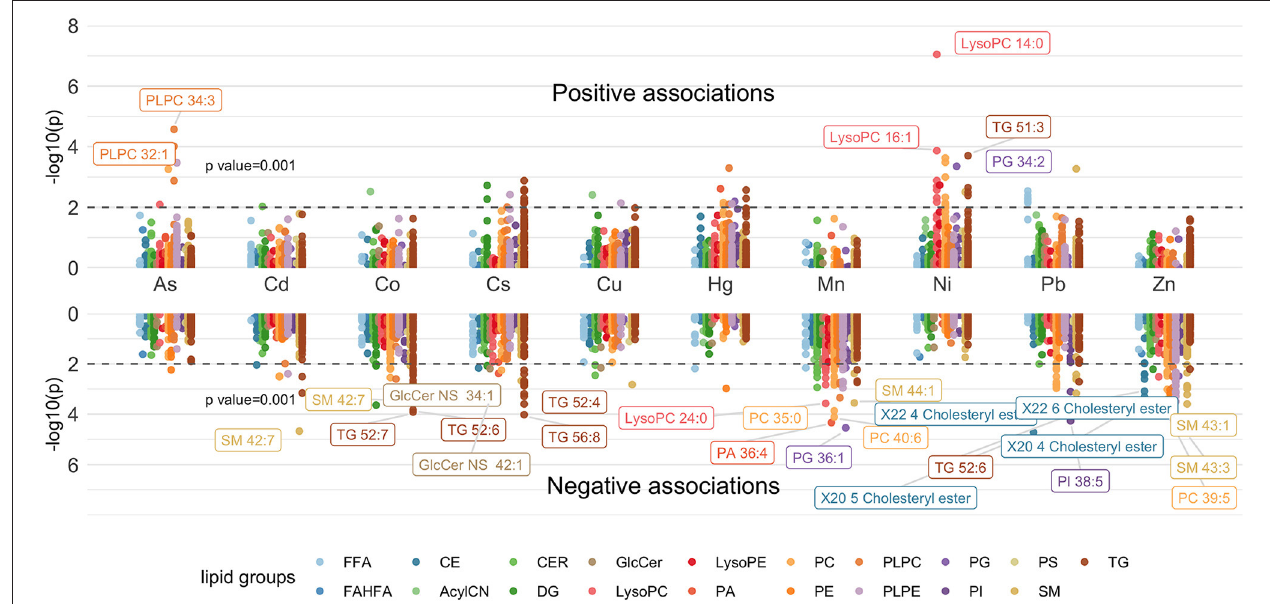
FIGURE 1 | Manhattan plot showing individual lipids associated with maternal metal/metalloid blood concentrations. Models were adjusted for maternal age, maternal education, fetal sex, pre-pregnancy BMI, weight gain during pregnancy.